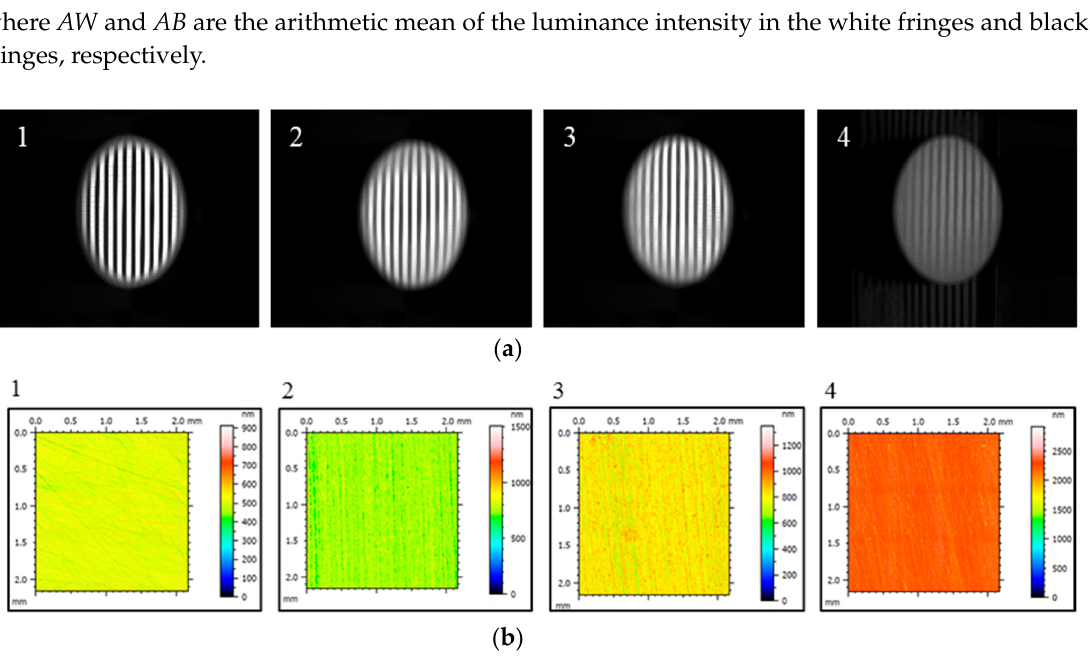
Figure 4. ( a ) Fringe pattern image captured by machine vision camera; ( b ) surface topography of test coupons measured by using Talysurf CCI HD.